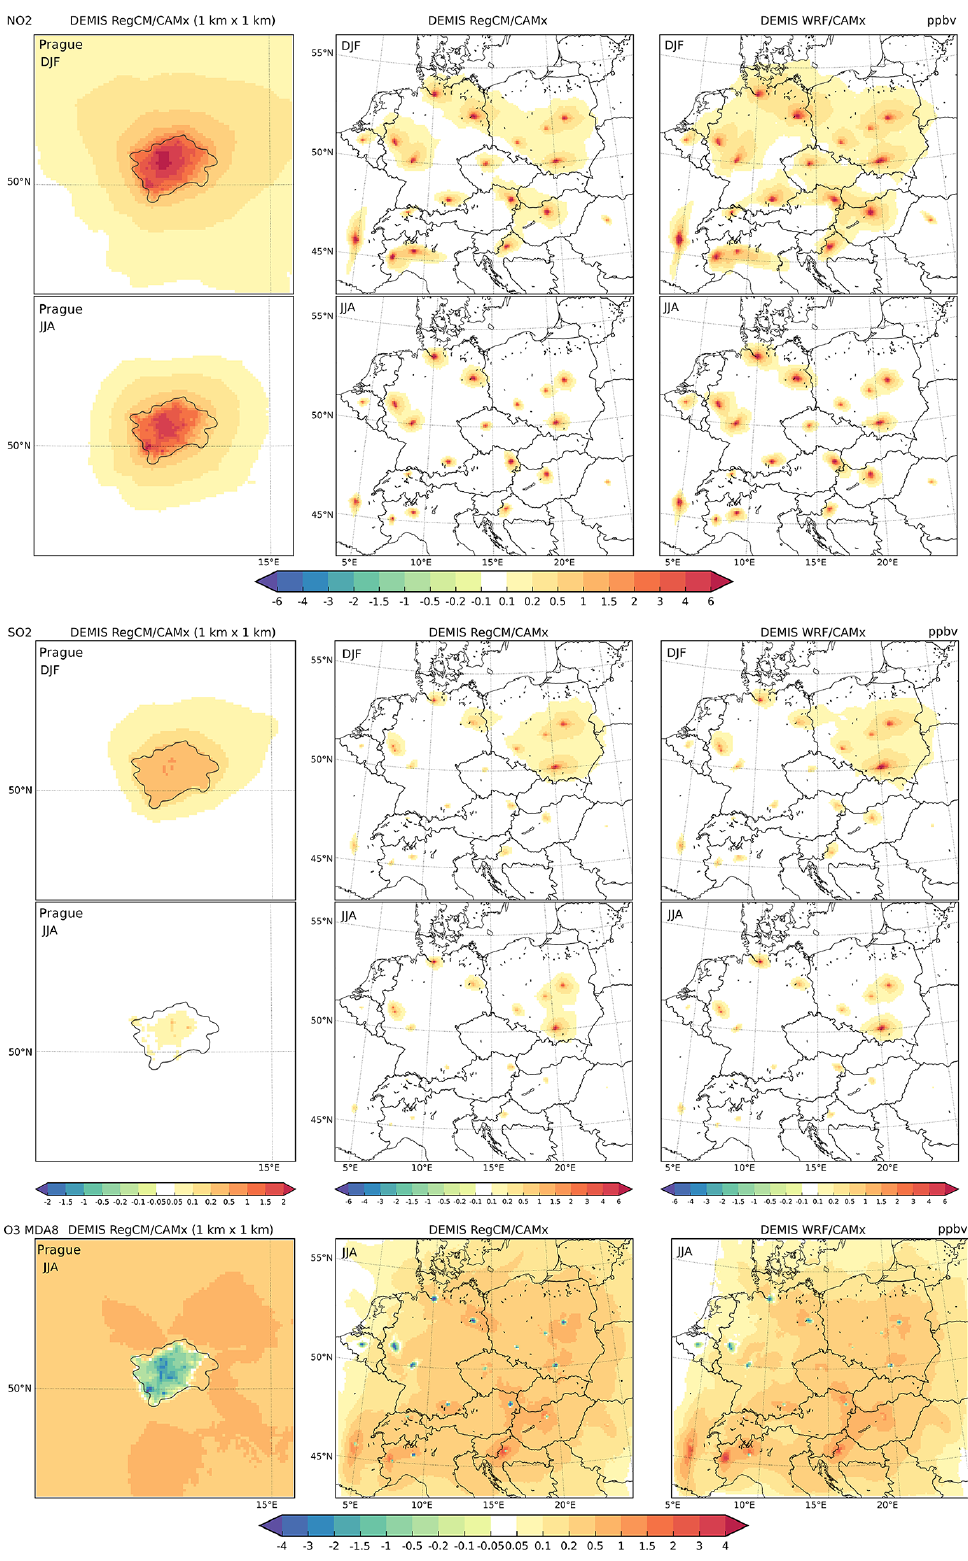
Figure 4. The spatial distribution of the 2015–2016 average emission impact (DEMIS) for NO 2 DJF and JJA (first and second row), SO 2 DJF and JJA (third and fourth row), and JJA MDA8 O 3 (fifth row). Columns represent the results from the 1km RegCM/CAMx (detail of Prague), 9km RegCM/CAMx, and 9km WRF/CAMx simulations. Units are in parts per billion by volume (ppbv). Atmos. Chem. Phys., 22, 12647–12674,